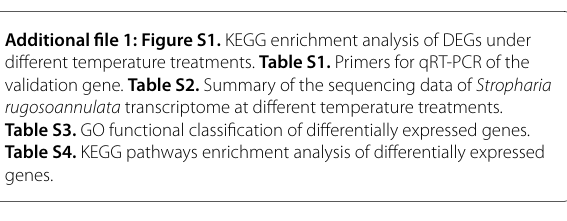
Table S3. GO functional classification of differentially expressed genes. Table S4. KEGG pathways enrichment analysis of differentially expressed